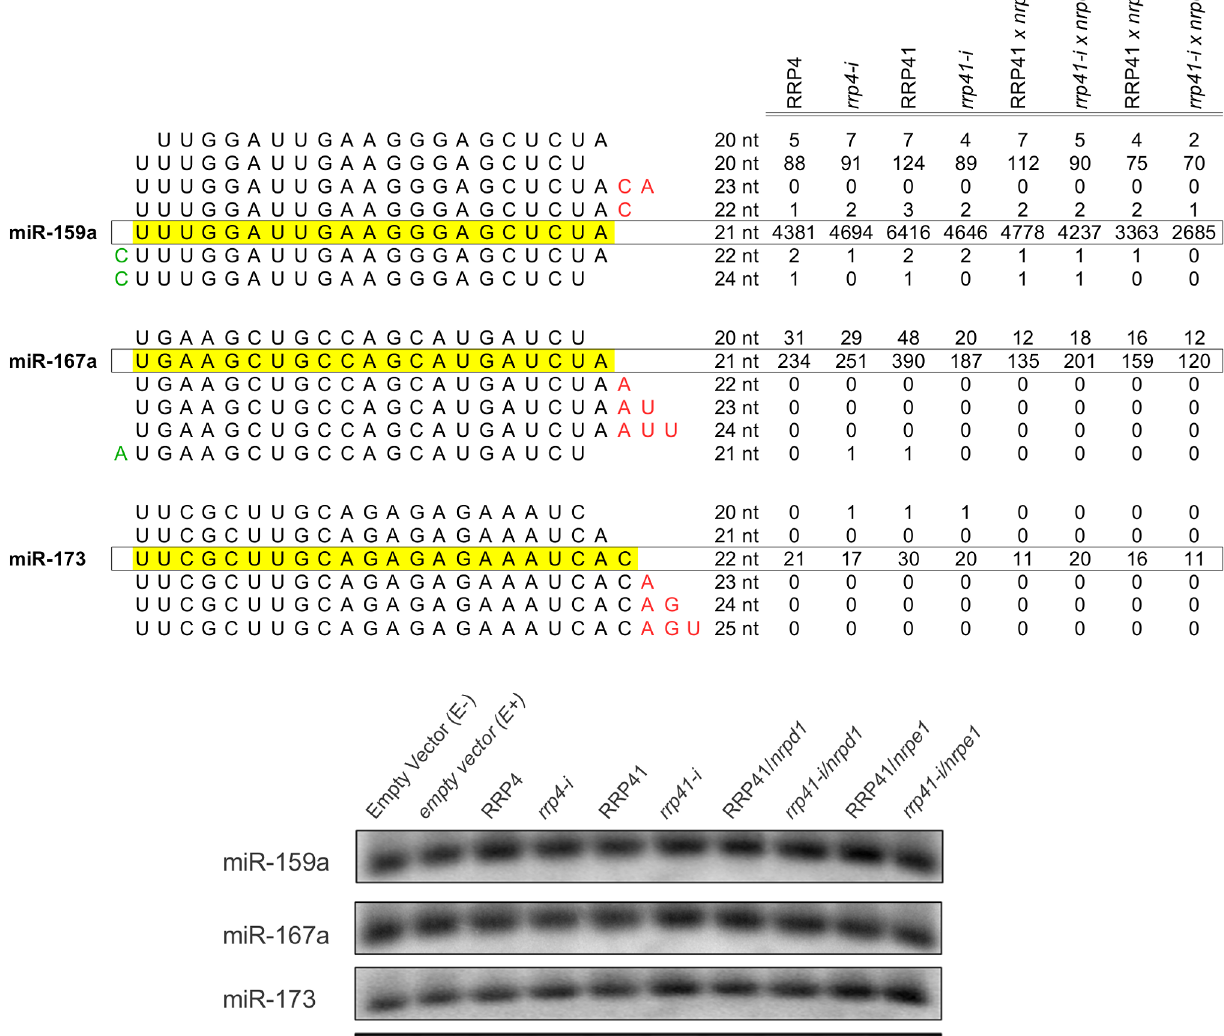
reported to correspond to region B top strand [30,31].